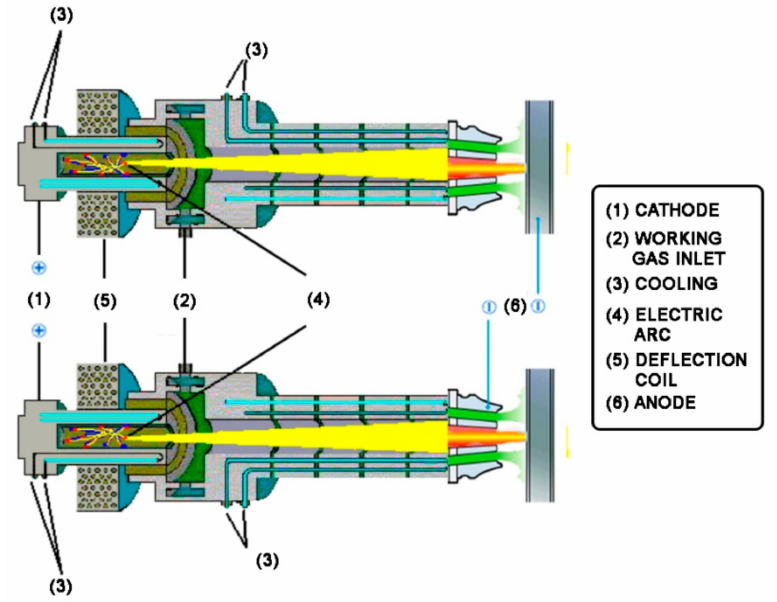
Figure 2. Transferred (above) and non-transferred (below) arc